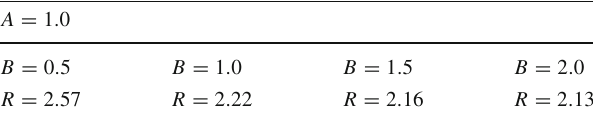
Table 2 Ratio R between the maximum of the D ∗ ¯ D ∗ mass distribution in Fig. 6 and the strength of the cusp at the D ∗ ¯ D ∗ threshold in Fig. 5